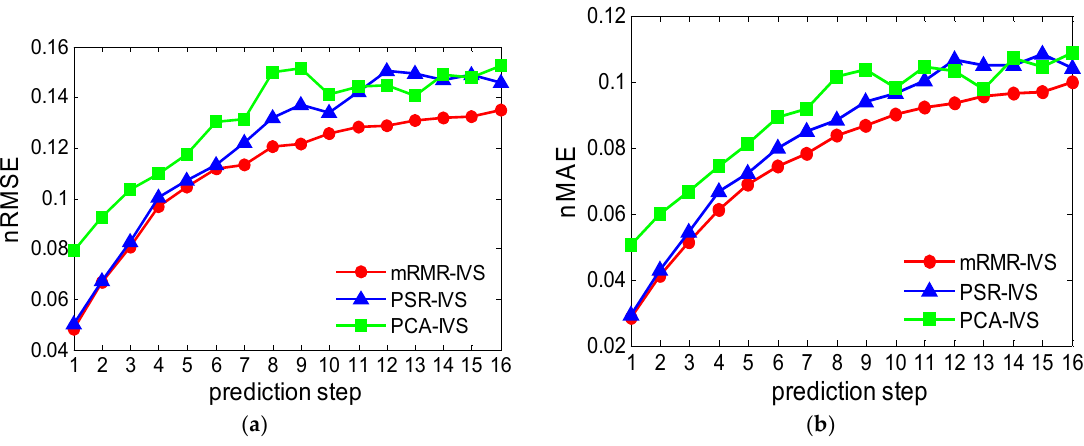
Figure 7. Error trend in different prediction steps of Anzishan farm: ( a ) nRMSE of test month; and ( b ) nMAE of test month.